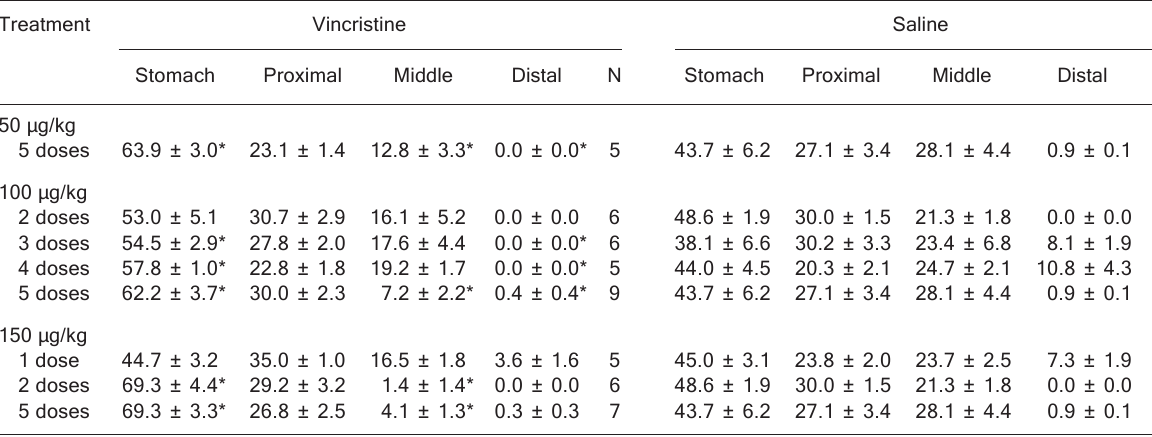
Table 1. Effect of intravenous vincristine administration on the dye recovery in the stomach, proximal, middle and distal small intestine (when present) of awake rats, 10 min after gavage administration of 1.5 mL of a 0.5 mg/mL phenol red solution in 5% glucose, 1 day after 5 doses of vincristine 50, 100, or 150 μ